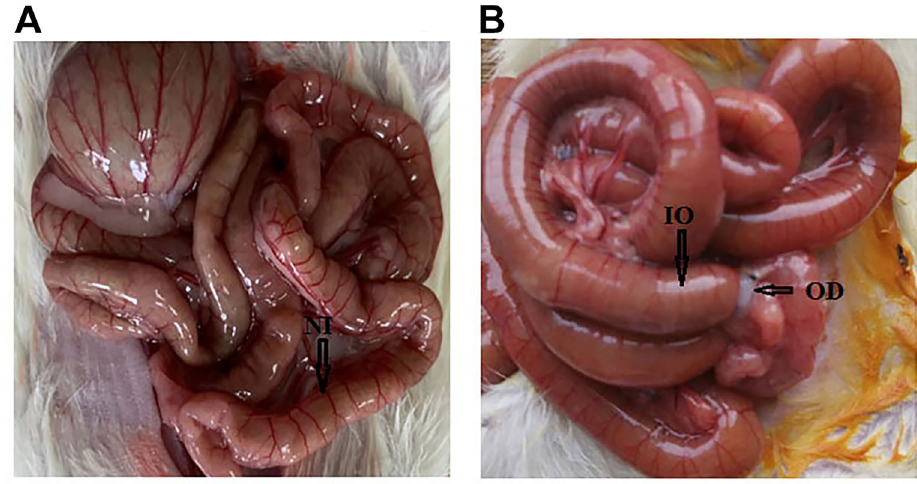
Figure 1. A , Normal intestinal tube (NT; arrow). B , Intestinal tube after 48 h of intestinal obstruction (IO; arrow) of experimental animals (short arrow indicates the obstruction device,